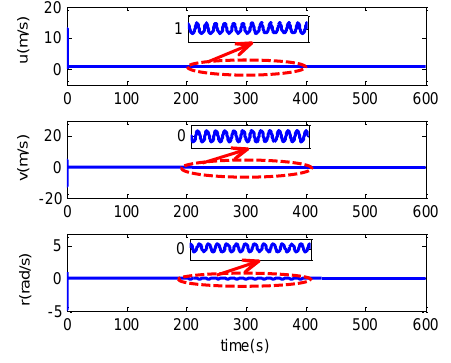
Figure 11. Linear and angular velocities of AUVs using the FFTC method.